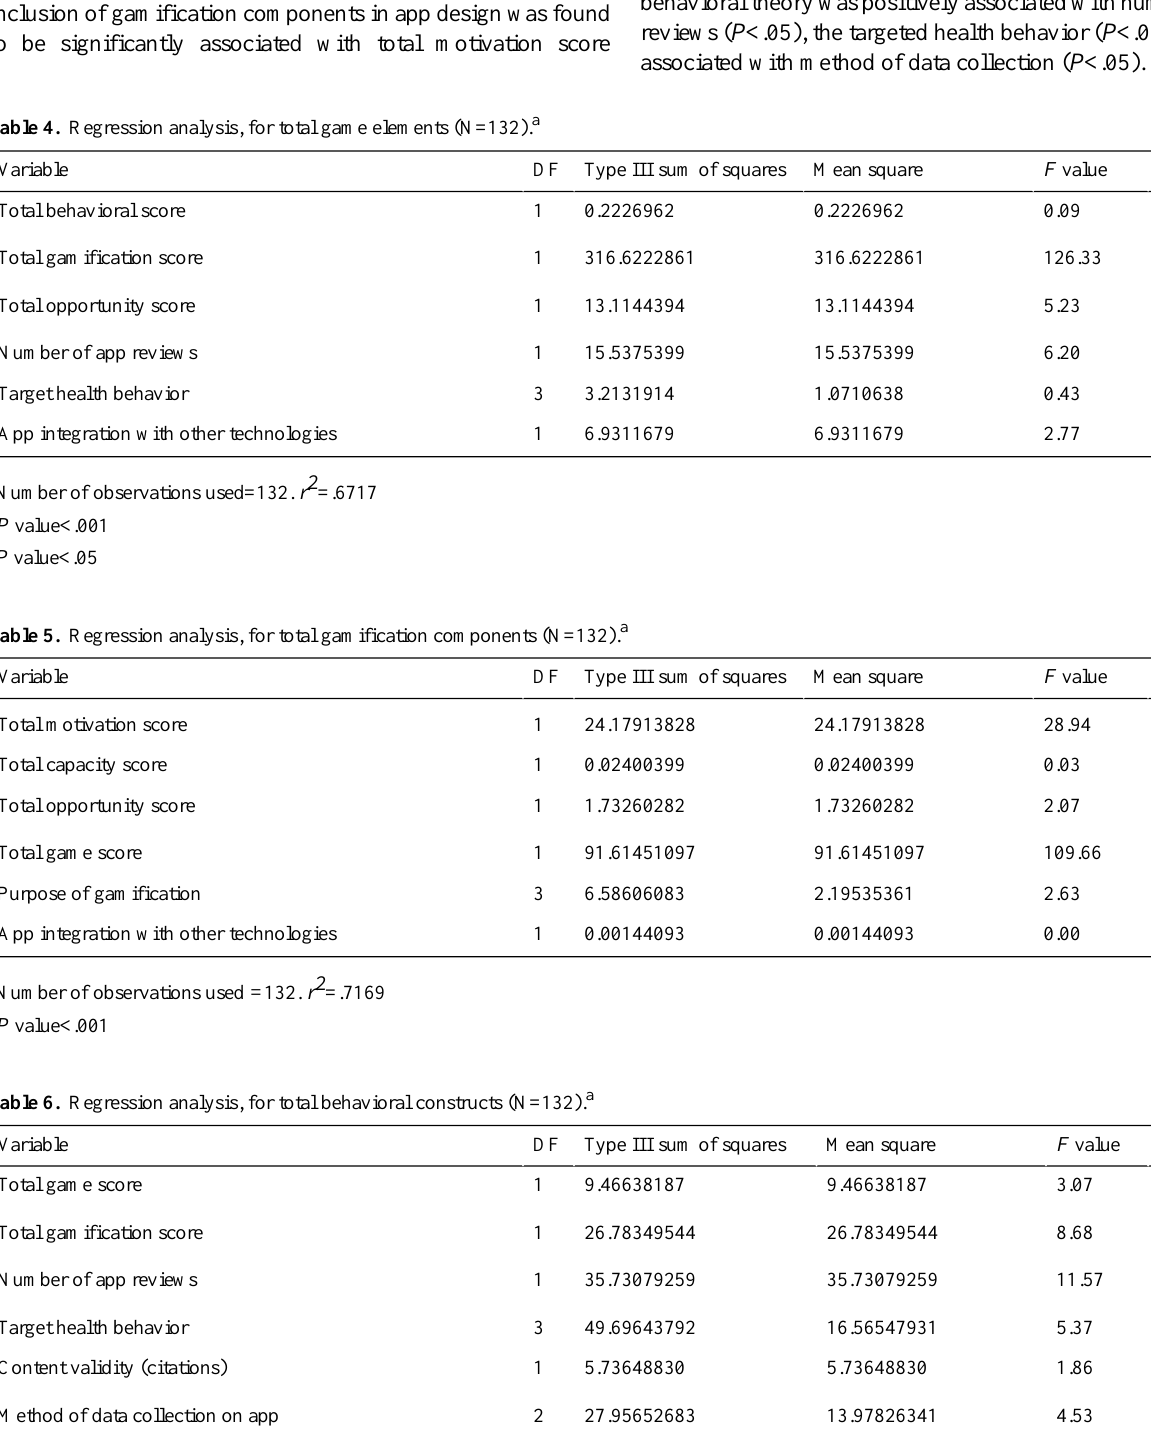
Table 4. Regression analysis, for total game elements (N=132). a